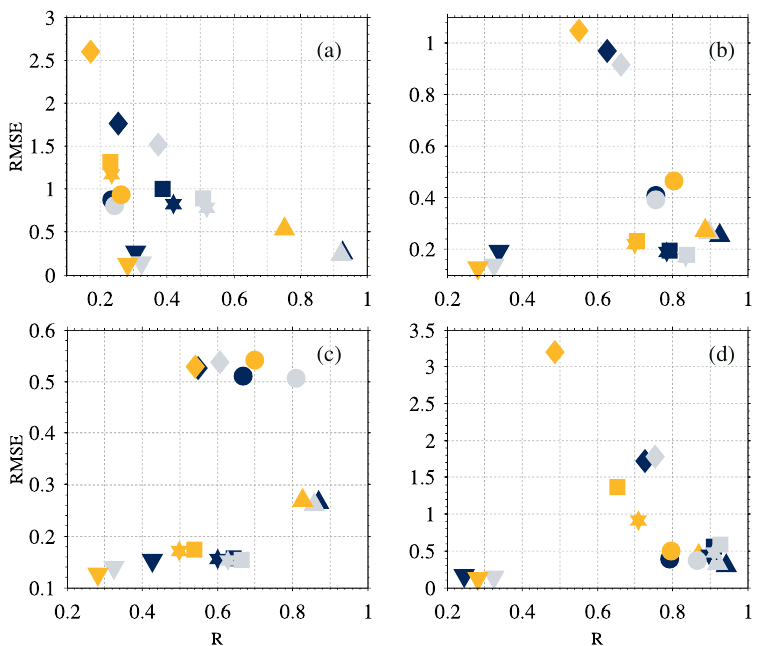
Figure 4. Correlation coefficient and RMSE obtained from the comparison between radar- and in situ-measured wave parameters. The three in situ devices are represented by a different color: buoy (blue), ADCP-E (grey) and ADCP-W (orange). The symbols denote the different wave parameters evaluated: energy period (T e ; star), mean period (T m ; square), peak period (T p ; diamond), significant wave height (H s ; triangle), mean wave direction (circle), and directional wave spread (spr; inverted triangle). The units of the RMSE values are meters, seconds, and radians for the wave height, period, and direction and wave spreading, respectively. Results are shown for three frequency bands and the full range of available frequencies: ( a ) 0.05–0.1 Hz; ( b ) 0.1–0.15 Hz; ( c ) 0.15–0.25; and ( d ) 0.05–0.25